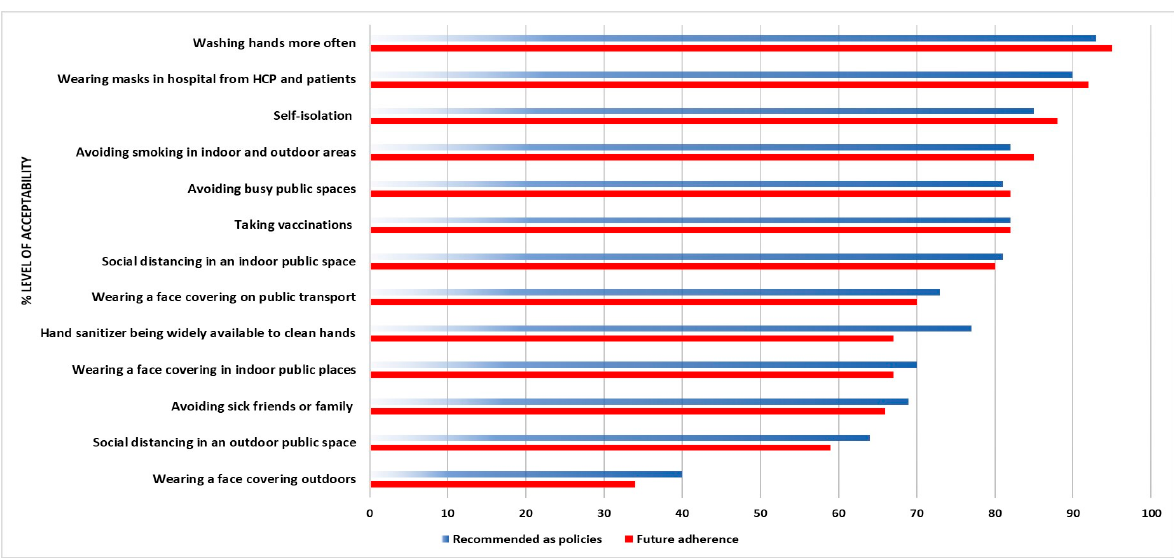
Figure 3. The acceptability of future policies for everyone at all times regarding respiratory virus infection control interventions by age.